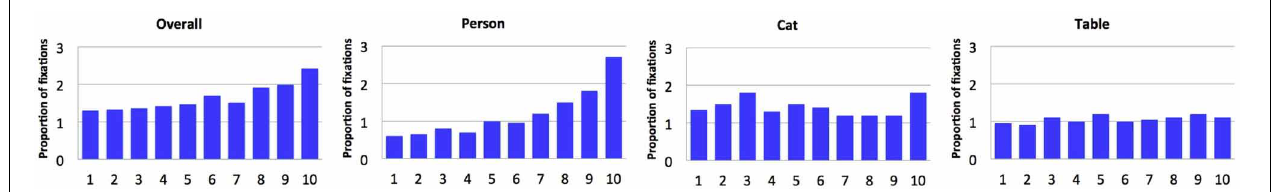
FIGURE 11 | Probability of fixation plotted as a function of object detector confidence score. Scores are binned such that bin 10 indicates the top 10%, bin 9 indicates the top 10–20%,